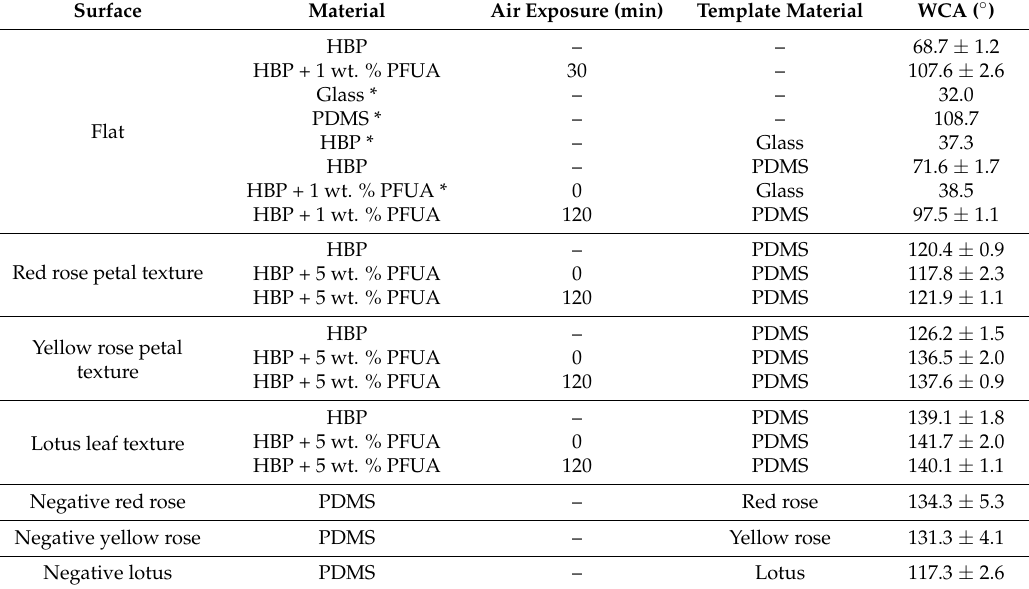
Table 2. Influences of air exposure prior to UV polymerization and concentration of PFUA on WCA of flat and texturized HBP and fluorinated HBP coatings. The WCA of flat HBP and fluorinated HBP polymerized in contact with glass and PDMS, of glass and of PDMS, and of PDMS negative replica of the plants are also